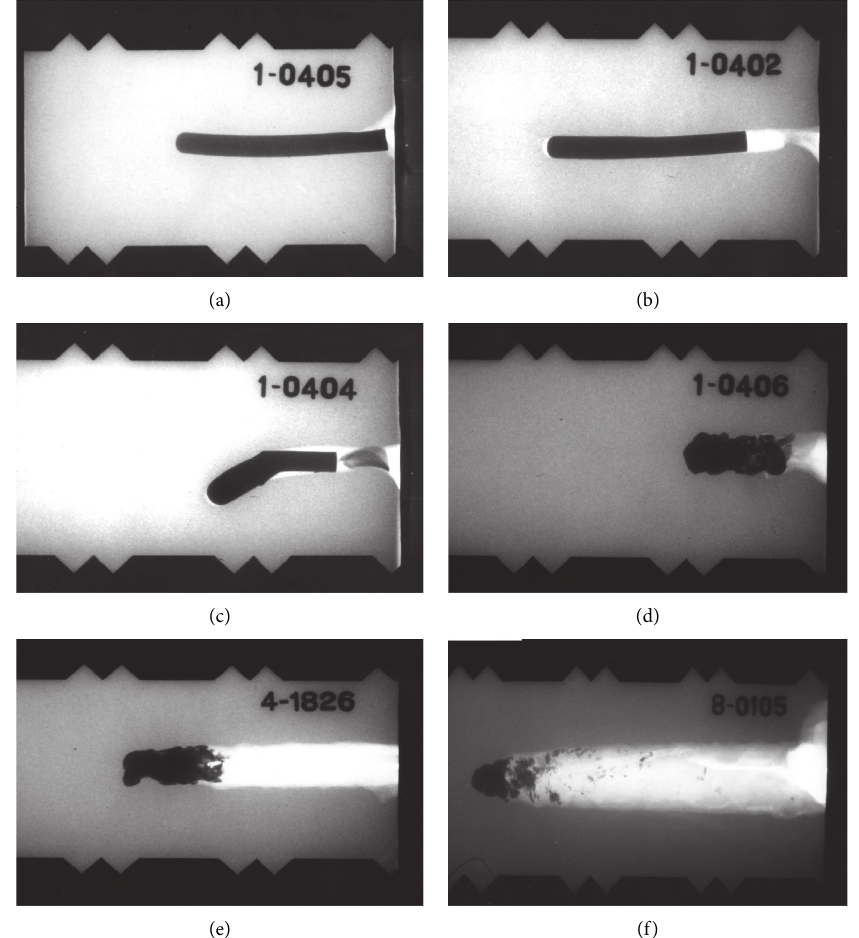
Figure 5: Posttest radiographs of targets and projectiles. (a) 781 m/s. (b) 932m/s. (c) 1037m/s. (d) 1193m/s. (e) 1802m/s. (f) 3075m/s.